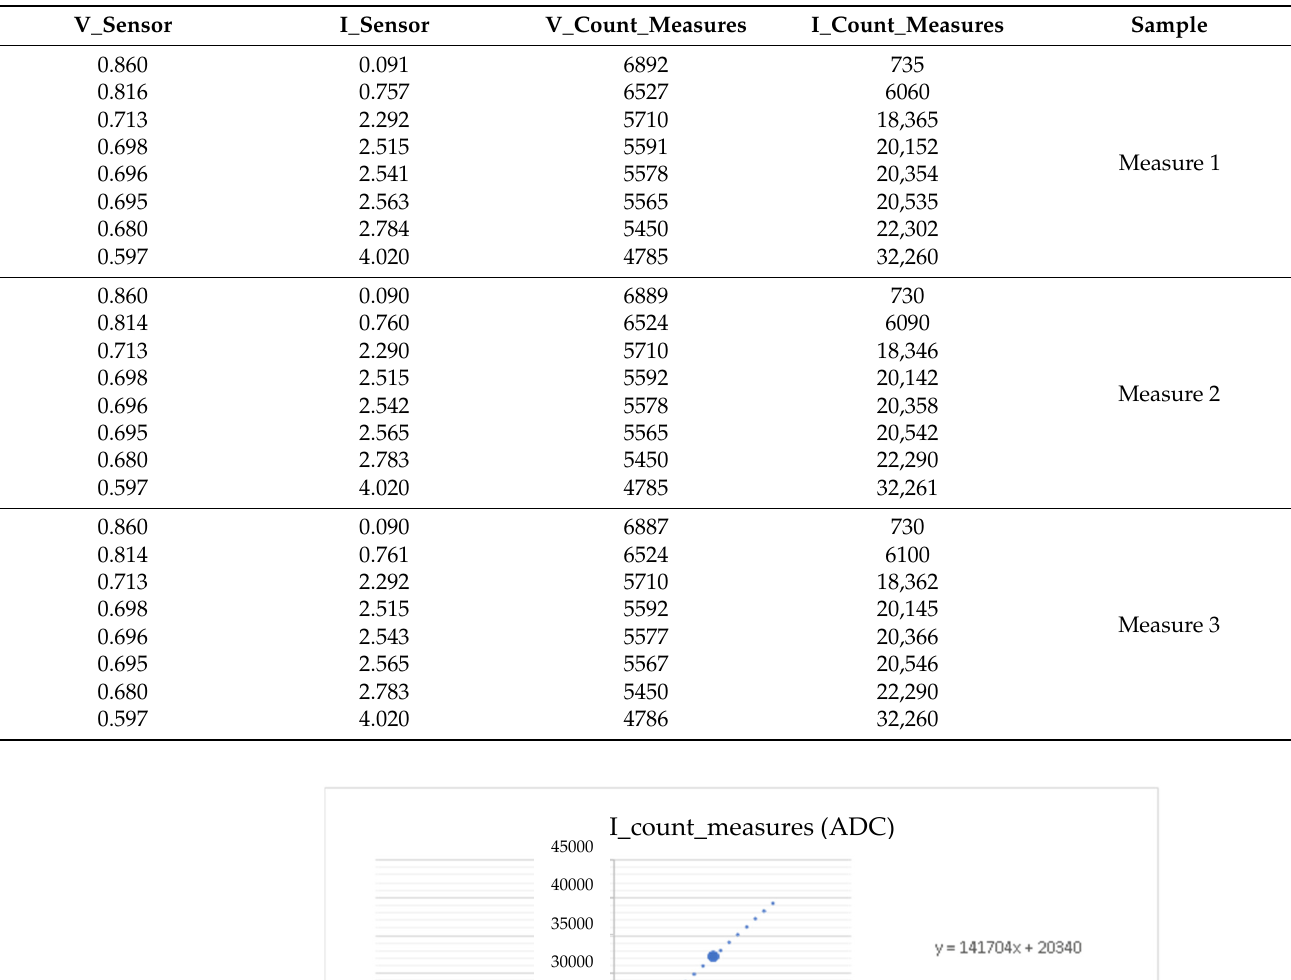
Table 2. Calibration of the system in the analog-digital converter (ADS1115).